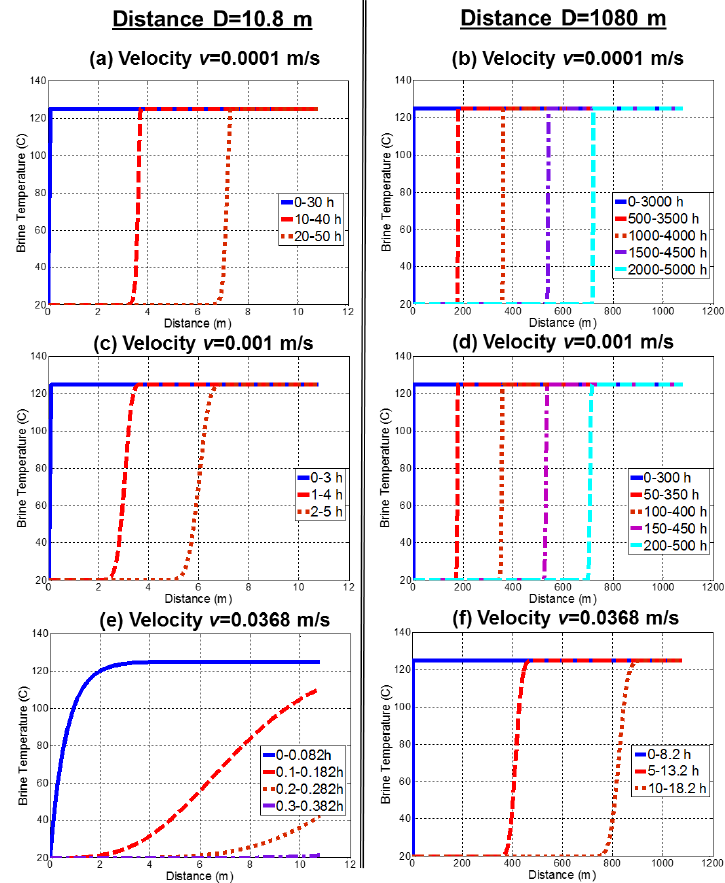
Figure A1. Brine temperature profile in the “tracer” perspective. Three different velocities are chosen. ( a , b ) v = 0.0001 m/s, ( c , d ) 0.001 m/s, and ( e , f ) 0.0368 m/s. Running distances are set to be the short distance D = 10.8 m and the longer distance D = 1080 m.